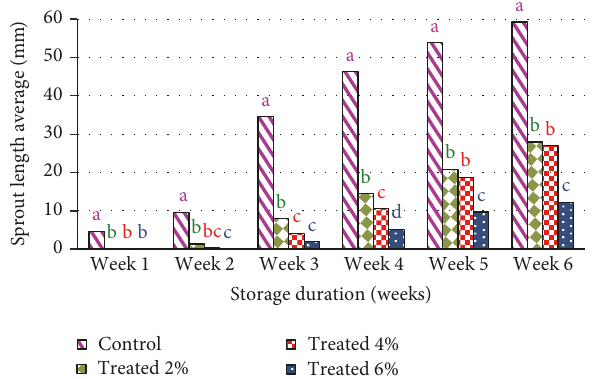
Figure 2: Effect of RCEO on potato sprouts length during storage. (a, b, c) Data (for the effect of RCEO on sprout length for each week) with different letters are significantly different ( 𝑝 ≤ 0.001 ).